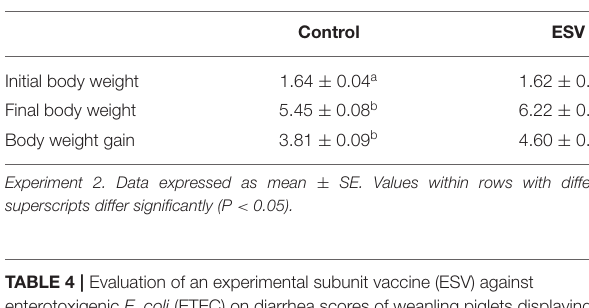
TABLE 4 | Evaluation of an experimental subunit vaccine (ESV) against enterotoxigenic E. coli (ETEC) on diarrhea scores of weanling piglets displaying colibacillosis.